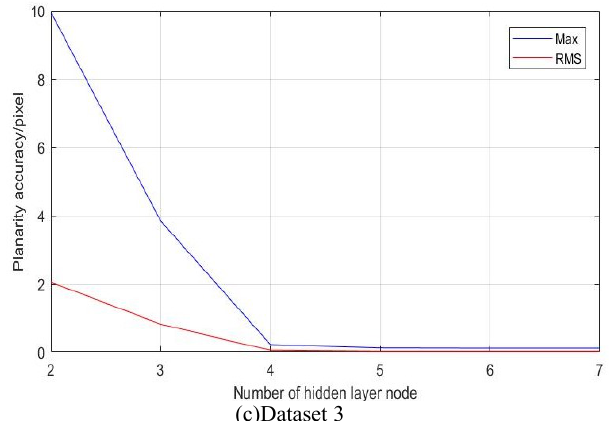
Figure 3. The terrain-indepedent BP neural network imagery geometrical model accuracy with different hidden layer node